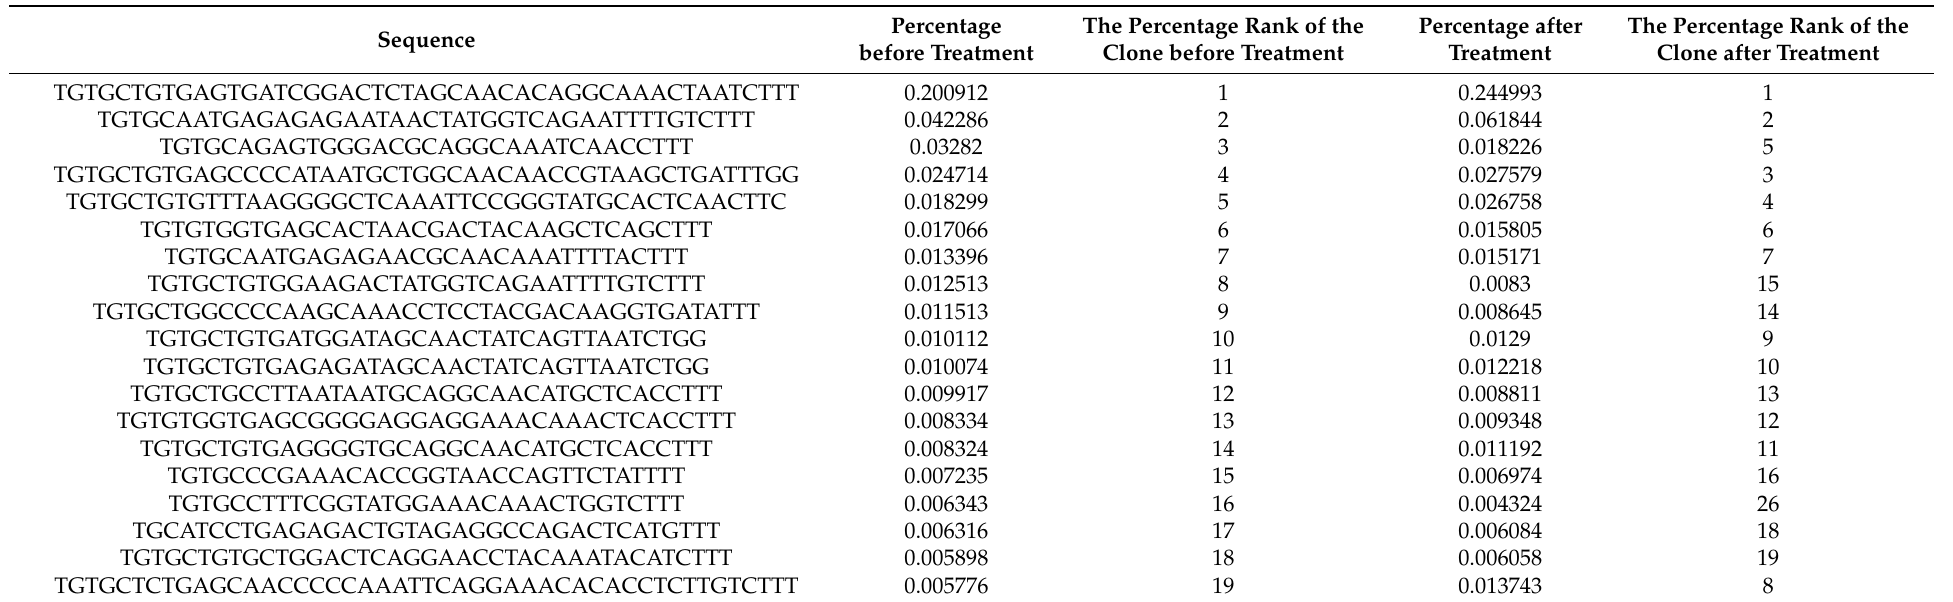
Table 7. Representative sequence of CD8+ T cell CDR3 before and after